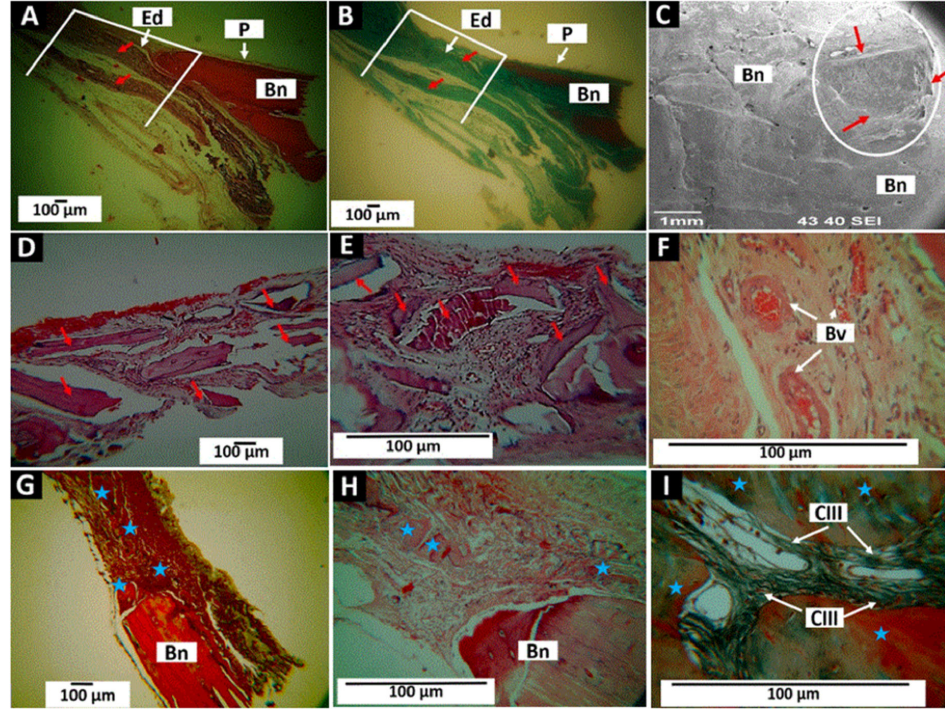
Figure 12. F3 (InterCollagen guide Extend membrane) material applied in intraosseous defects in cranial bones. ( A ): Implantation at 30 days at 4 × . HE technique. ( B ): Implantation at 30 days at 4 × . GT technique. ( C ): Implantation at 30 days at 40 × . SEM technique. ( D ): Implantation at 60 days at 10 × . HE technique. ( E ): Implantation at 60 days at 10 × . GT technique. ( F ): Implantation at 60 days at 100 × . HE technique. ( G ): Implantation at 90 days at 4 × . HE technique. ( H ): Implantation at 90 days at 40 × . HE technique. ( I ): Implantation at 90 days at 100 × . HE technique. P: Periosteum. Ed: Empty defect. Bn: remaining bone. Bv: blood vessel. CIII: Collagen type III. Red arrows: Material. Blue stars: new bone